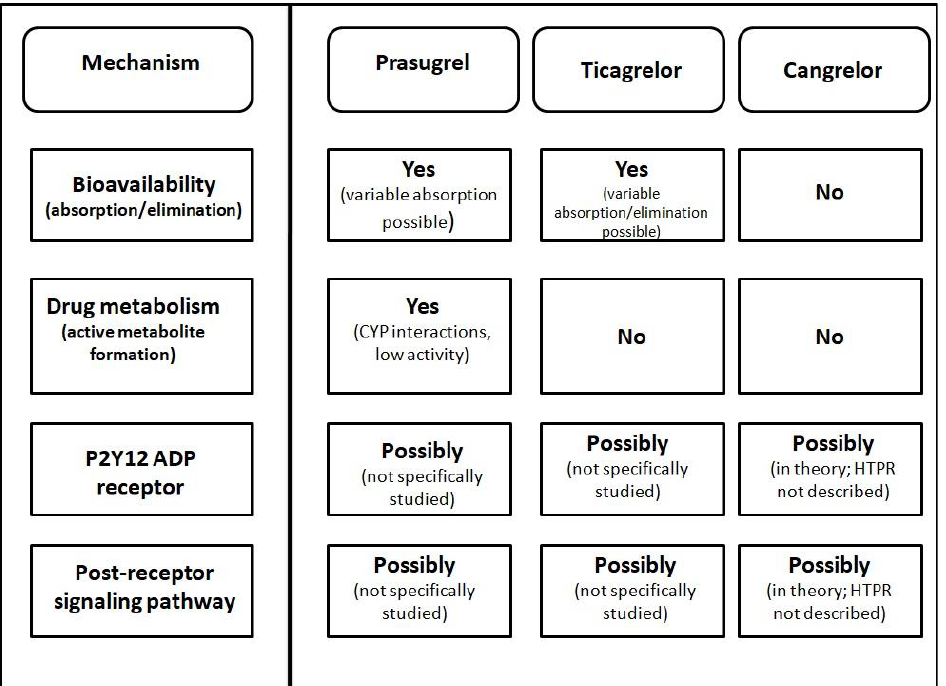
Figure 1. Possible mechanism of HTPR on novel-generation ADPRB [59]. ADP — adenosine diphos- phate; ADPRB — P2Y12 ADP receptor blockers; CYP — cytochrome P450 enzyme; HTPR — high on- treatment platelet reactivity.